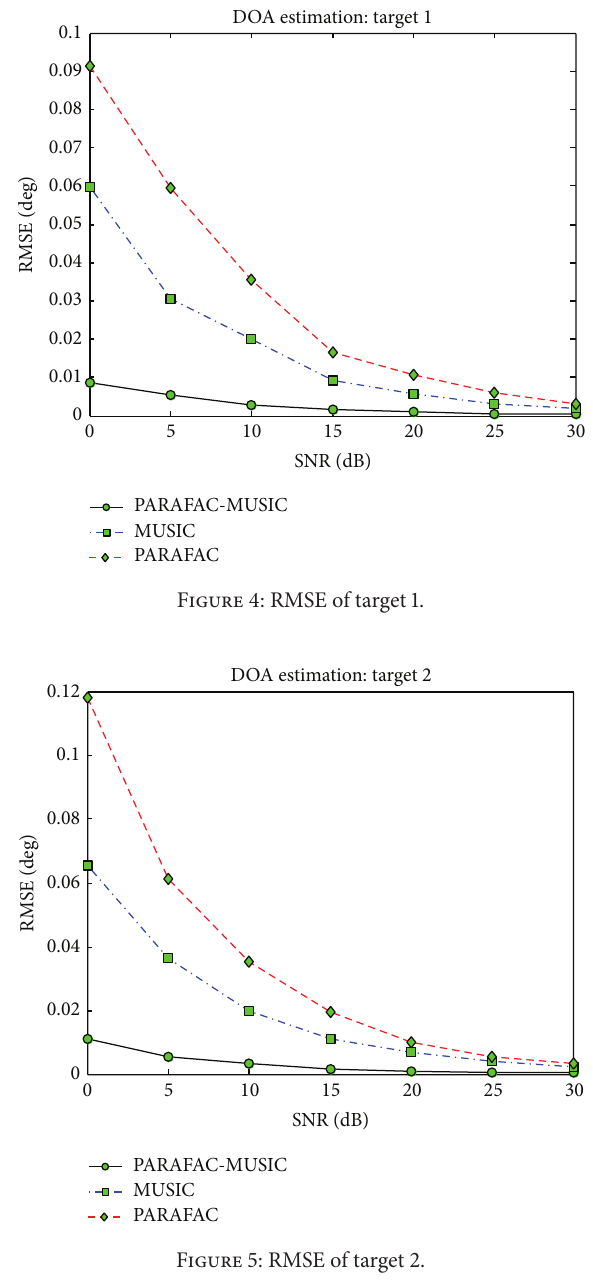
Figure 5: RMSE of target